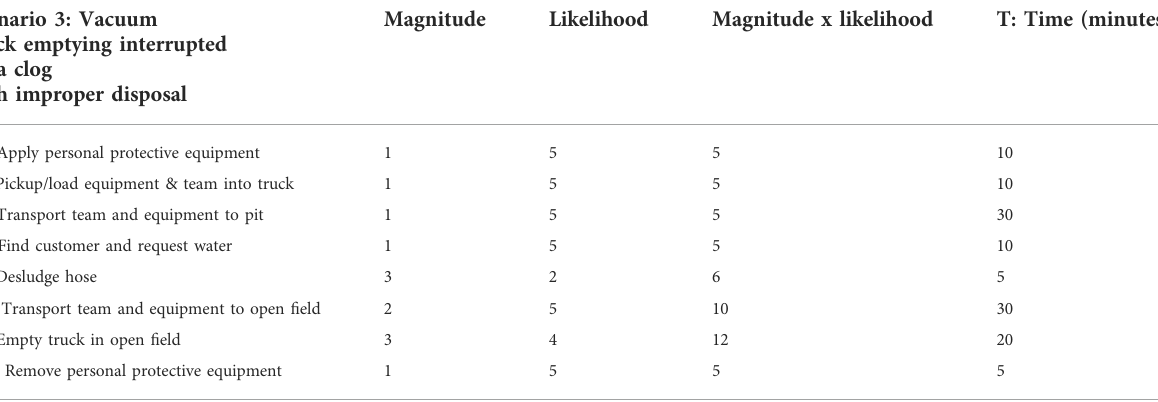
TABLE 5 Scenario 3. Excerpt of facial touch risk scores for vacuum truck emptying interrupted by a clog with improper disposal. Solid lines between rows denotes to a break in steps. Operator enters the truck for cleaning. See Supplementary Material for the complete set. Scenario 3: Vacuum truck emptying interrupted by a clog with improper